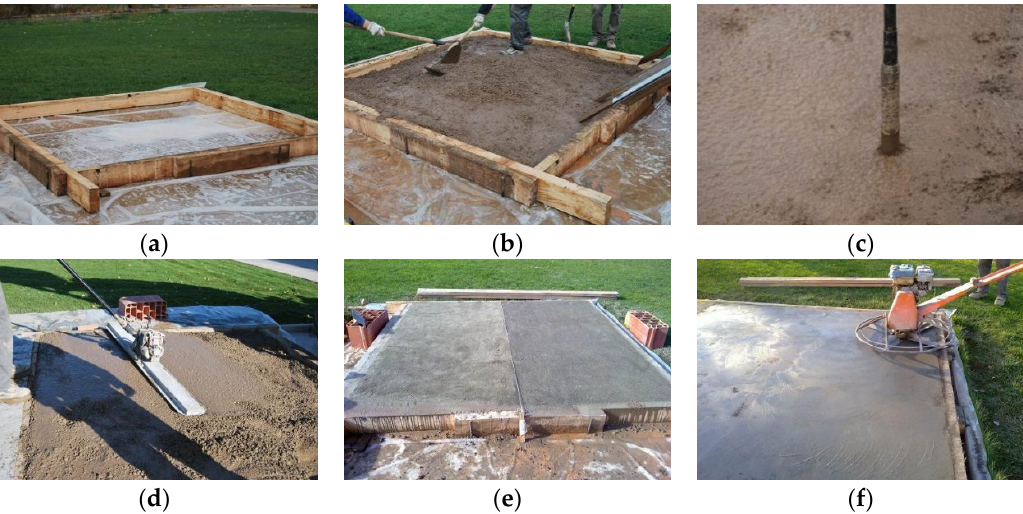
Figure 7. Construction process of the slabs: ( a ) construction of the formwork; ( b ) concrete casting; ( c ) concrete vibration with a needle vibrator; ( d ) surface smoothing with a vibrating screed; ( e ) slabs finished without surface treatment; ( f ) mechanical scrubbing of surface slabs.